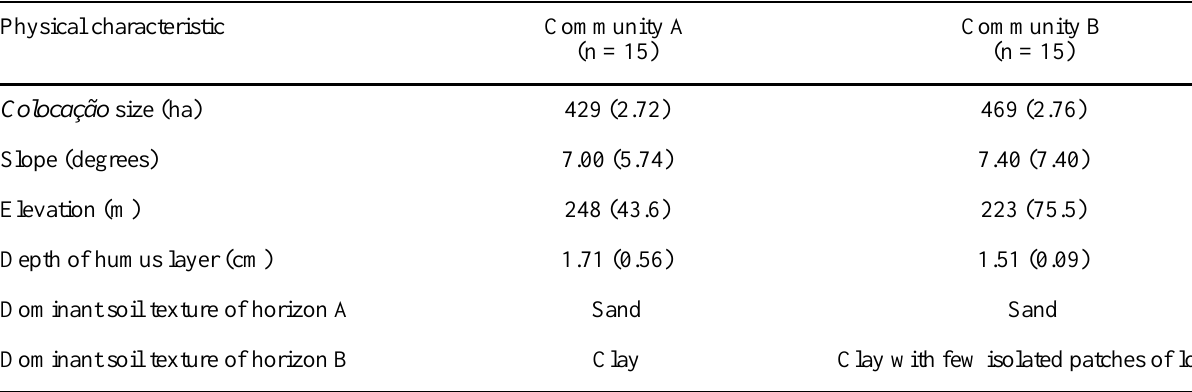
Table 1. Physical characteristics of the two study sites. Values are the mean